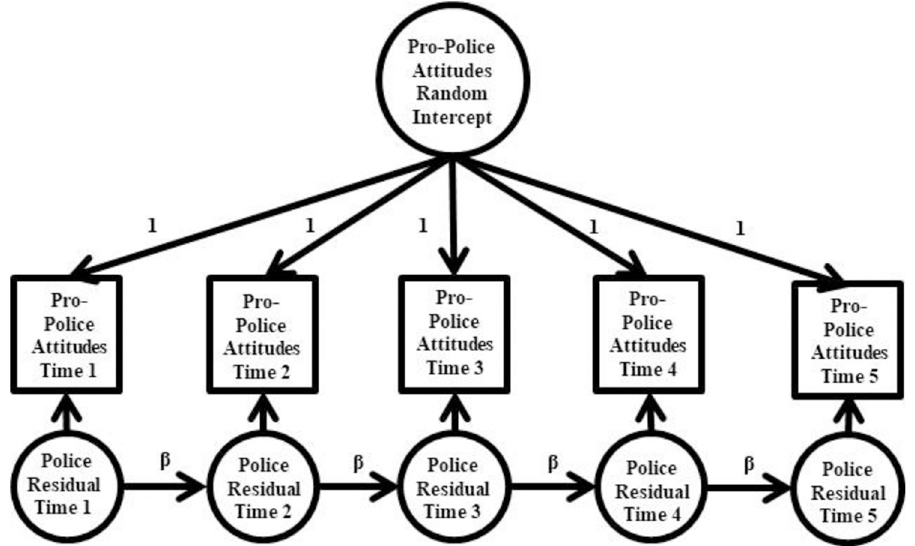
Fig 1. Random Intercept Autoregressive Model (RIAM). β = autoregressive path. Variances and mean structure omitted from figure for clarity of presentation. All factor loadings were fixed to 1. All autoregressive paths were freely